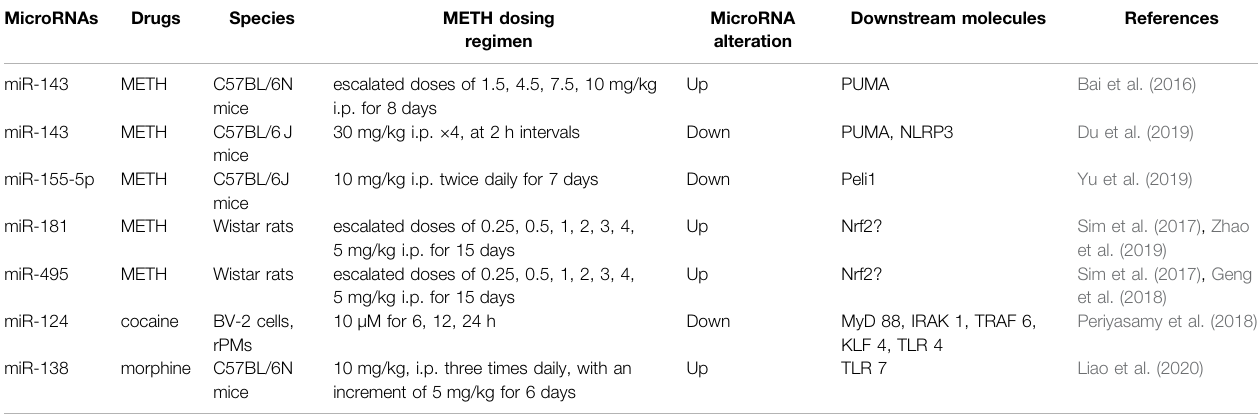
TABLE 1 | MiRNAs in METH-induced neurotoxicity.